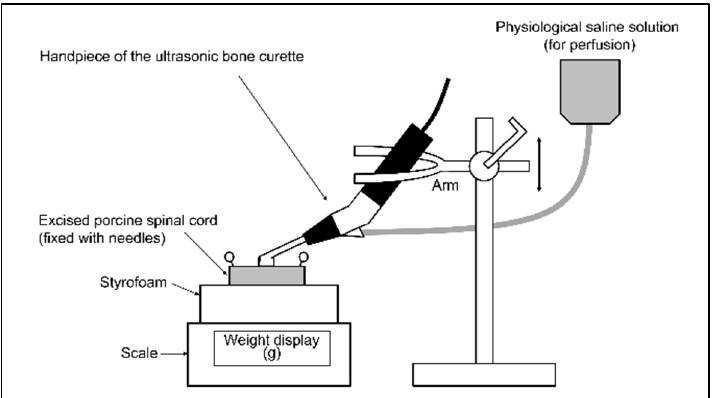
Figure 2. Schematic diagram of the experimental apparatus. A block of hard Styrofoam was placed on the scale, and the spinal cord specimen was fixed with needles. The ultrasonic bone curette hand-